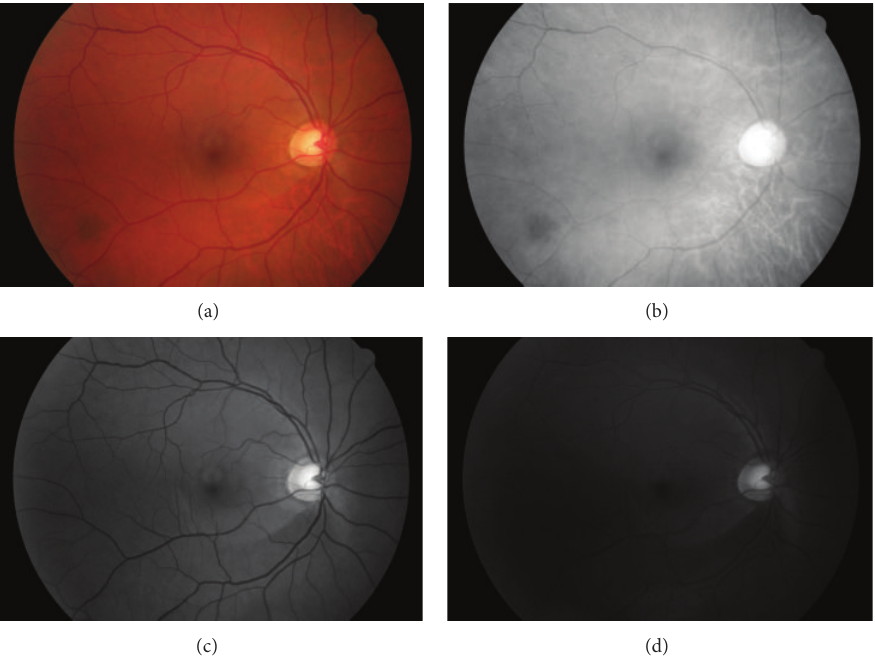
Figure 3: A fundus image (a) and its RGB decomposition showing the oversaturated red (b), the well-illuminated green (c), and the under- illuminated blue (d) channels.